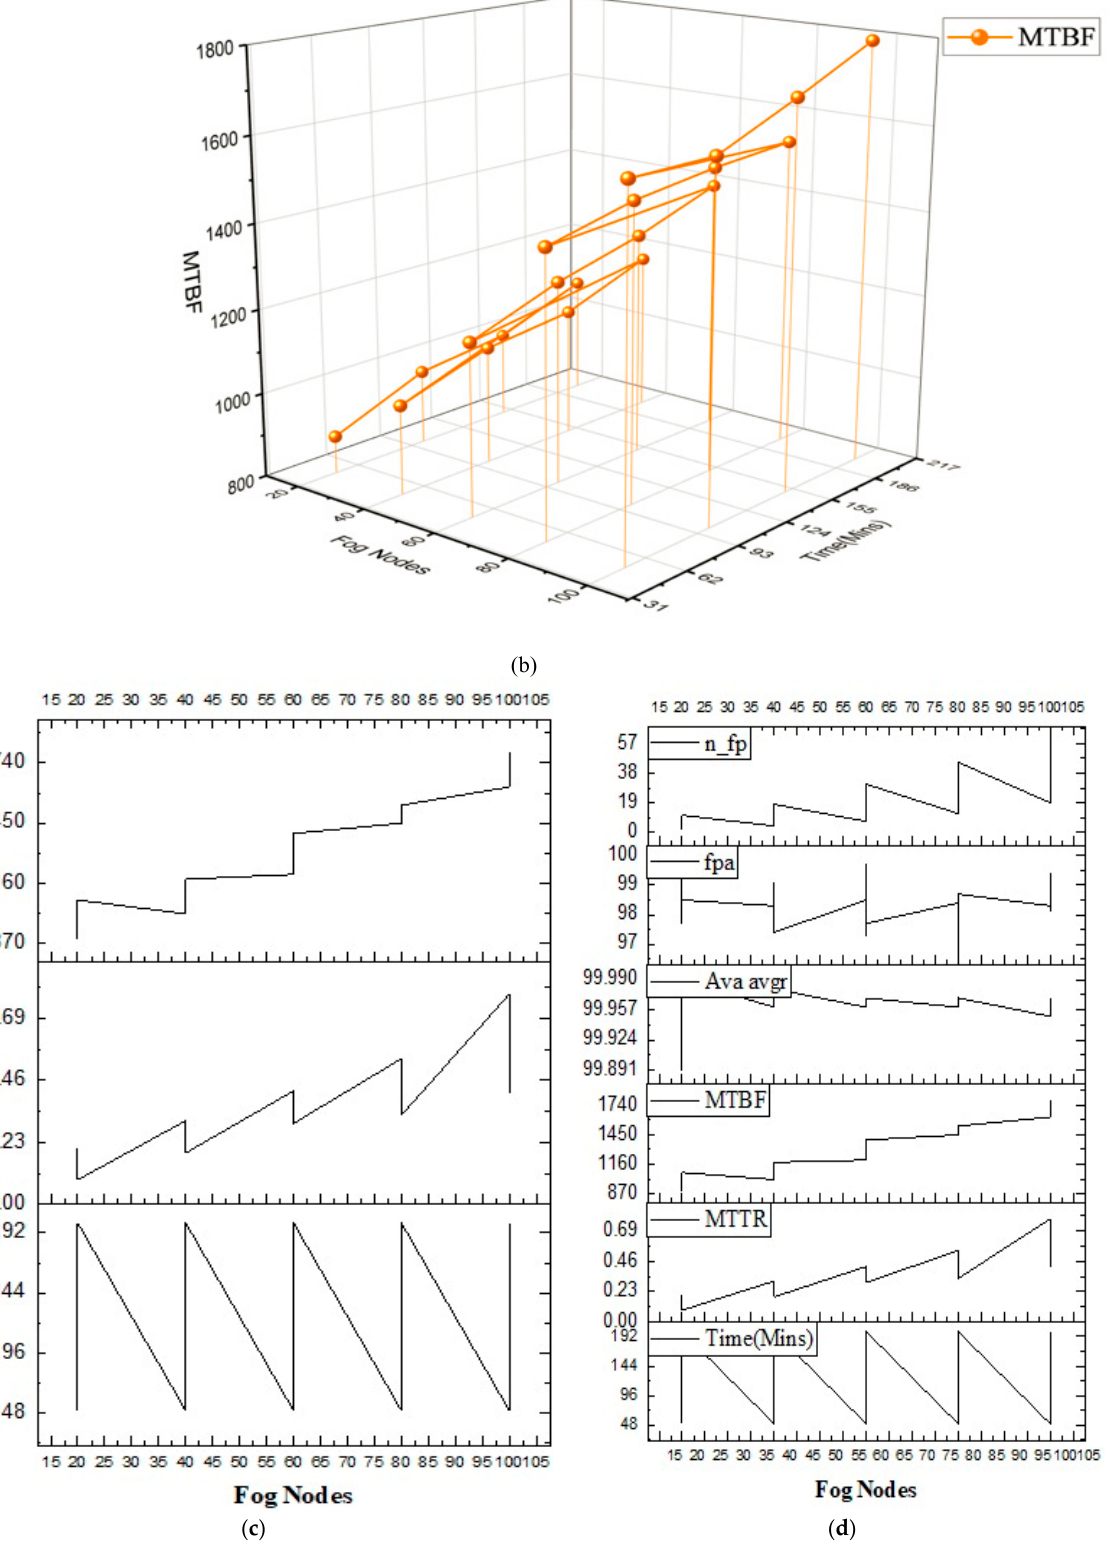
Figure 12. ( a ): Fog nodes, time, and MTTR. ( b ): Fog nodes, time, and MTBF. Represents the relationship between various parameters of MTBR and MTBF. ( c ): Fog nodes, time, MTTR, and MTBF. ( d ): Fog nodes, Time, MTTR, MTBF, Ava_Avgr, fpa,